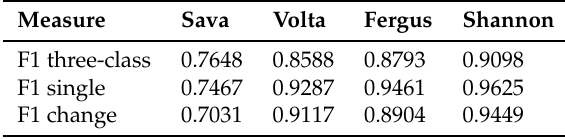
Table 4. Accuracy of CC+PP for SARwCopt-10 expressed in terms of different metrics for all ROIs. Measure